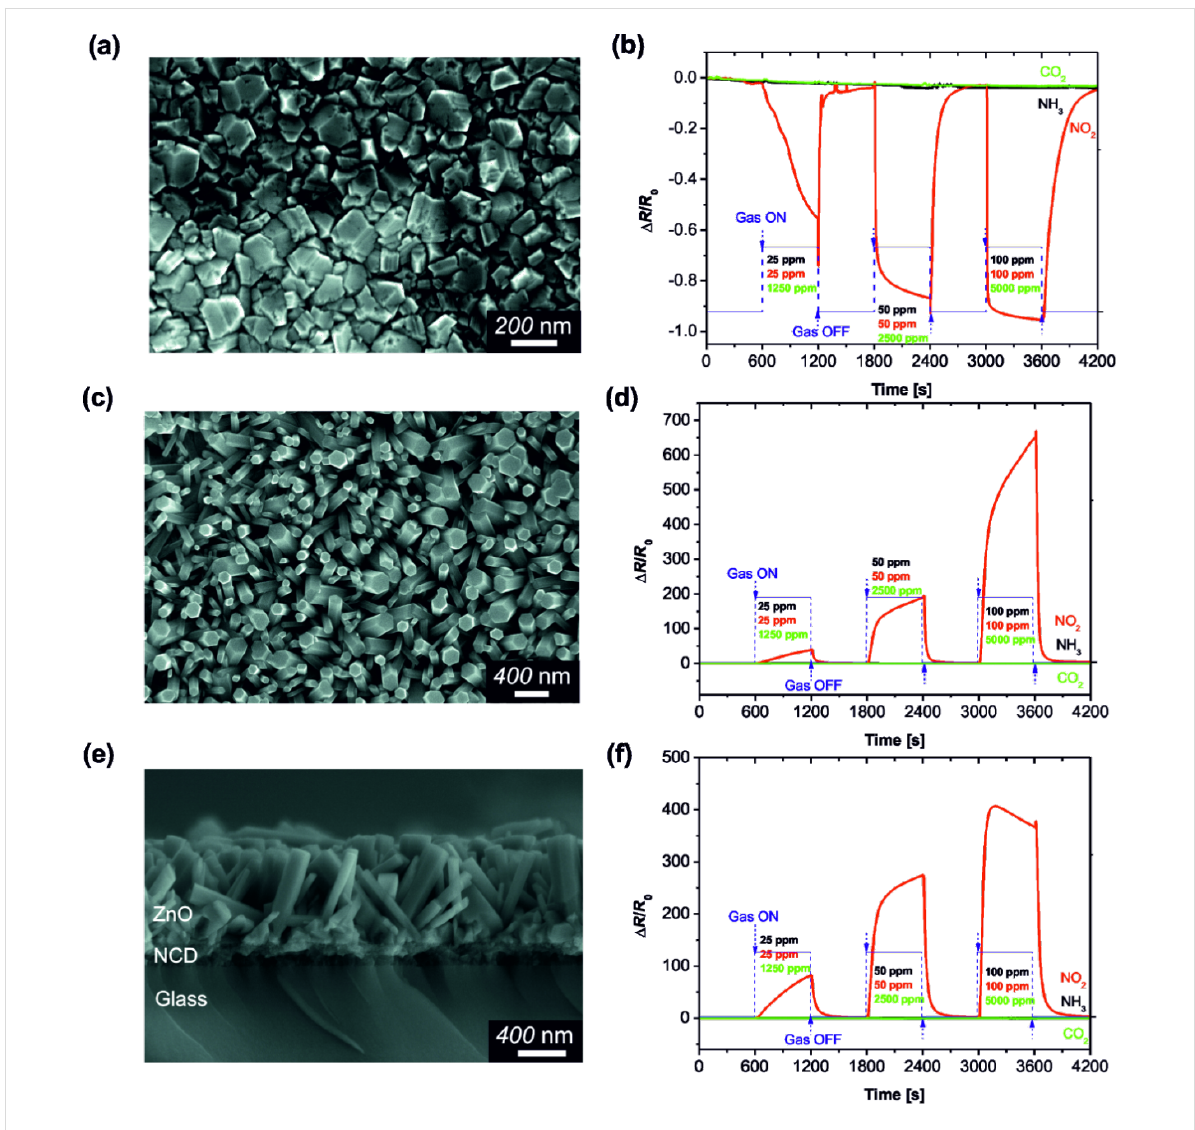
Figure 2: SEM surface morphology and corresponding plot of sensor response as a function of the time at a fixed temperature of 150 °C: (a,b) NCD thin film, (c,d) ZnO nanorods, (e,f) hybrid ZnO NRs/NCD-coated sensor substrate with Au/Ti